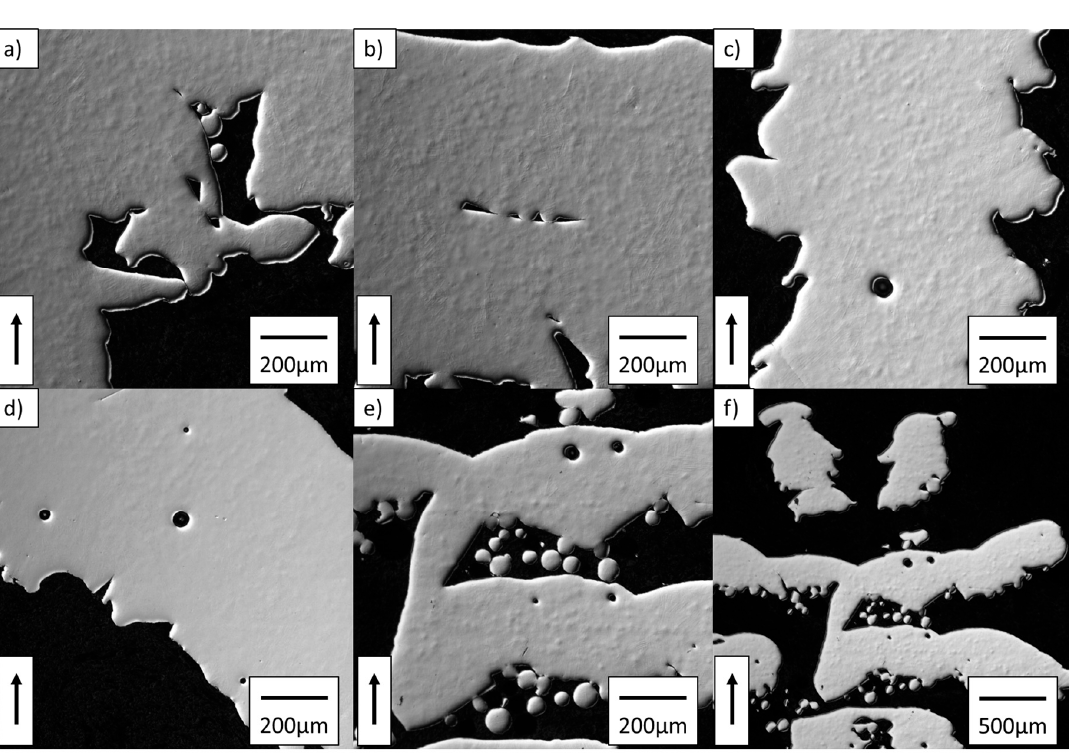
Figure 8. Optical micrographs showing example pores as found in the three CT-scanned lattices. The build direction is indicated by the arrow. ( a – c ) show defects in cubic lattices; at the beginning of the horizontal truss, elongated pores in horizontal trusses and round pores in vertical trusses, respectively; ( d ) shows round pores only in diamond-like lattices; ( e ) pores in trusses from trapped particles in the middle of the nodes of the re-entrant cube; ( f ) shows a zoom out on the same area.